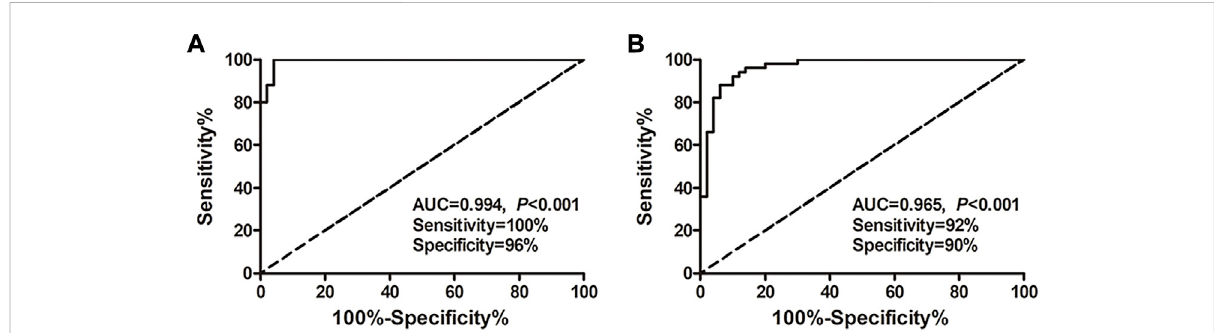
FIGURE 4 PerformanceoftheexosomalmiRNApanelinHCCdiagnosisbyROCcurveanalysis. (A) DiagnosisofHCCfromthehealthygroup. (B) Diagnosis of HCC from the hepatic cirrhosis group. The X -axis indicated a false positive rate, and Y -axis indicated a true positive rate. HCC, hepatocellular carcinoma; ROC curve, receiver operating characteristic